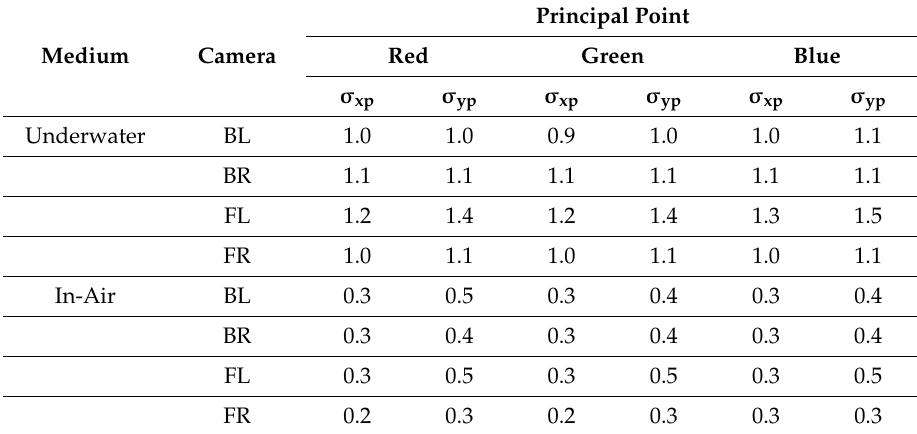
Table 6. Principal point standard deviations from the CMB